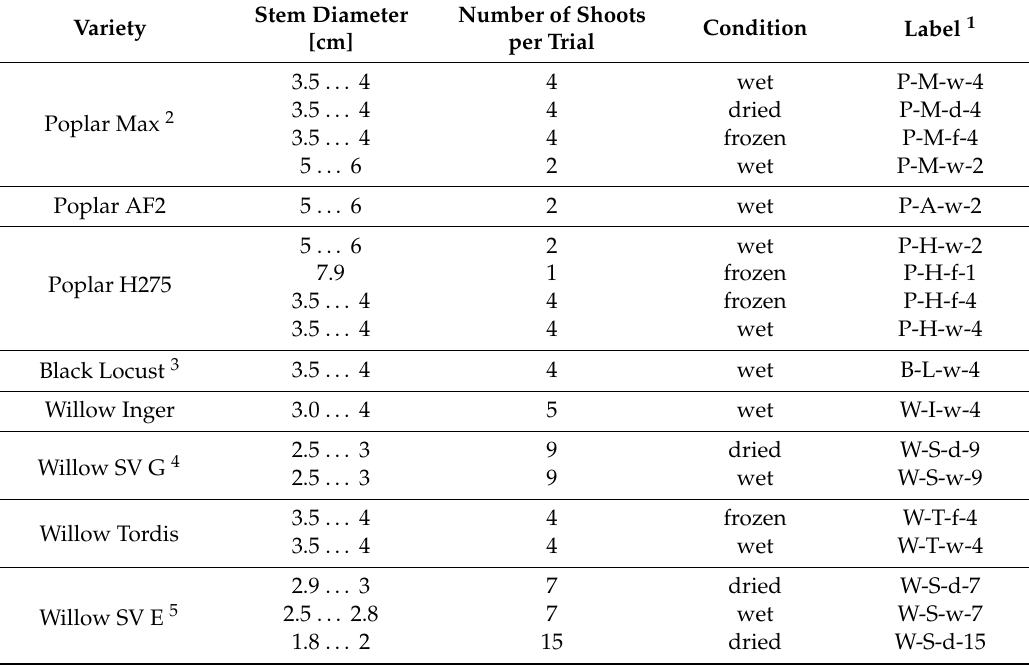
1 Labelling: Variety-Clone-Condition-No of shoots per trial. Example for labelling: W-S-d-15 = W illow, clone S alix viminalis , d ried shoots, 15 shoots per chipping trial. 2 Poplar Max1 and Max4. 3 Black Locust 1jS1 / 0. 4 Salix